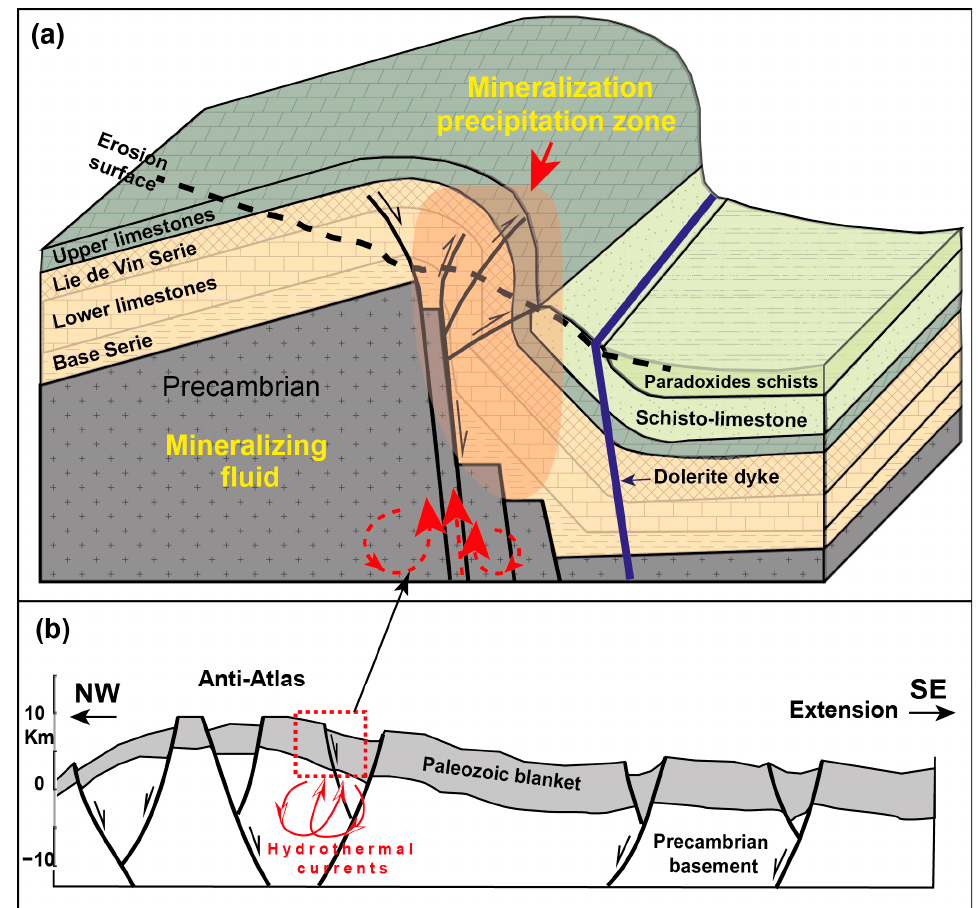
Figure 14. ( a ) Model illustrating the occurrence of copper mineralization in the Paleozoic cover of the Anti-Atlas. ( b ) Schematic NNW–SSE geological section of the Anti-Atlas during the Triassic– Liassic extension (reactivation of deep fractures and creation in the cover of steep normal faults and associated